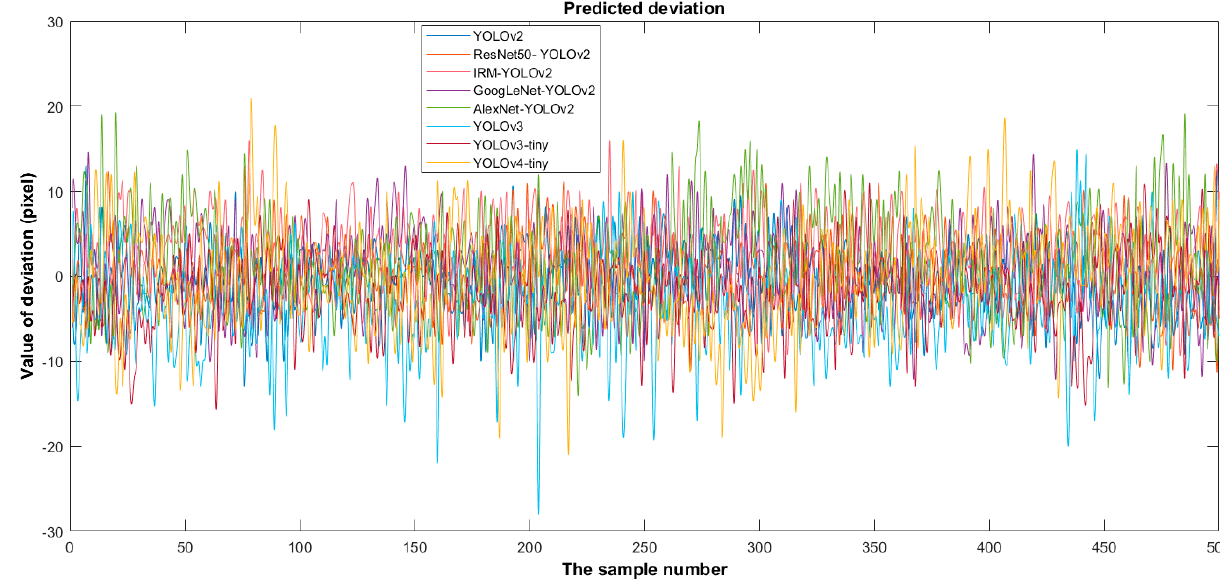
Figure 10. Deviation distribution of detection results of different algorithms.